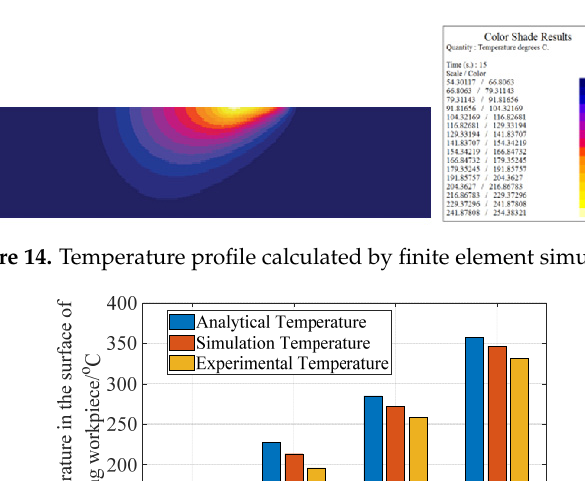
Figure 13. Temperature profile calculated by the analytical method.